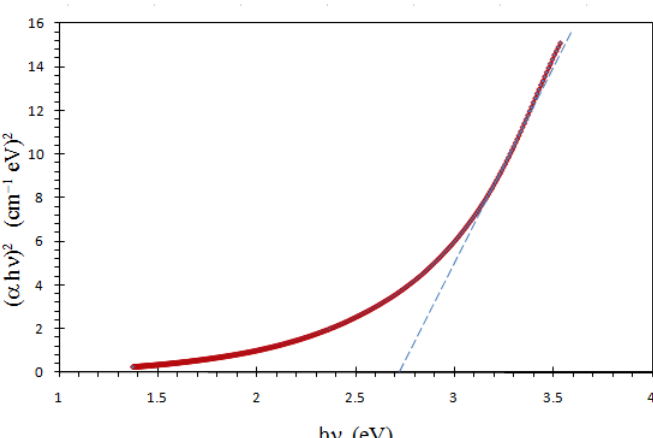
O thin films get from oxidation of In metallic 2 3